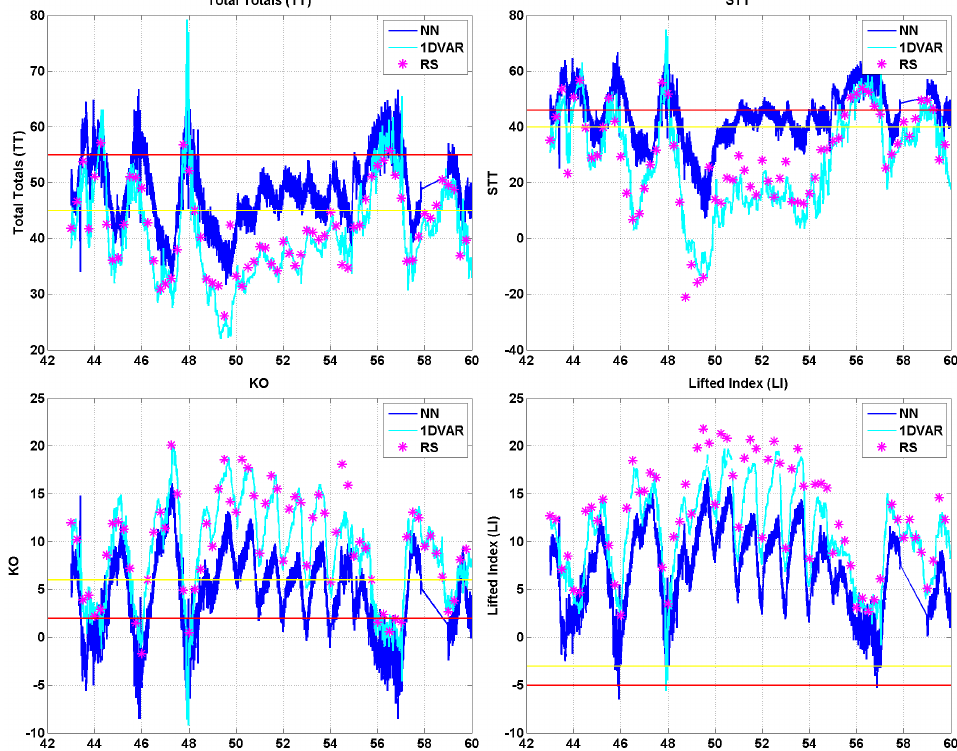
Figure 5. As in Fig. 3 but for (clockwise from top-left panel) total totals, STT, LI, and KO. The horizontal yellow and red lines indicate thresholds for moderate and high potential,